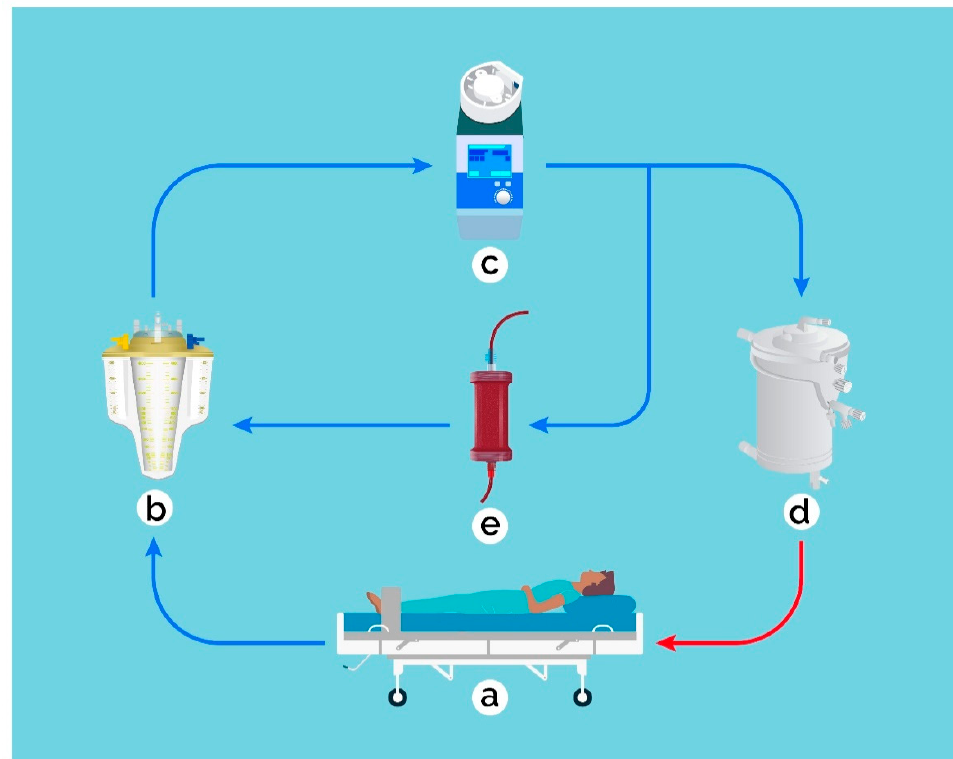
Figure 1. The hemoadsorption (HA) device was installed into the venous cardiopulmonary bypass, so that the blood (blue: venous, red: arterial) was pumped via a side arm back into the reservoir. The average flow rate via the HA device was 500 mL/min. ( a ) patient, ( b ) venous reservoir, ( c ) roller pump, ( d ) oxygenator, ( e ) HA device.